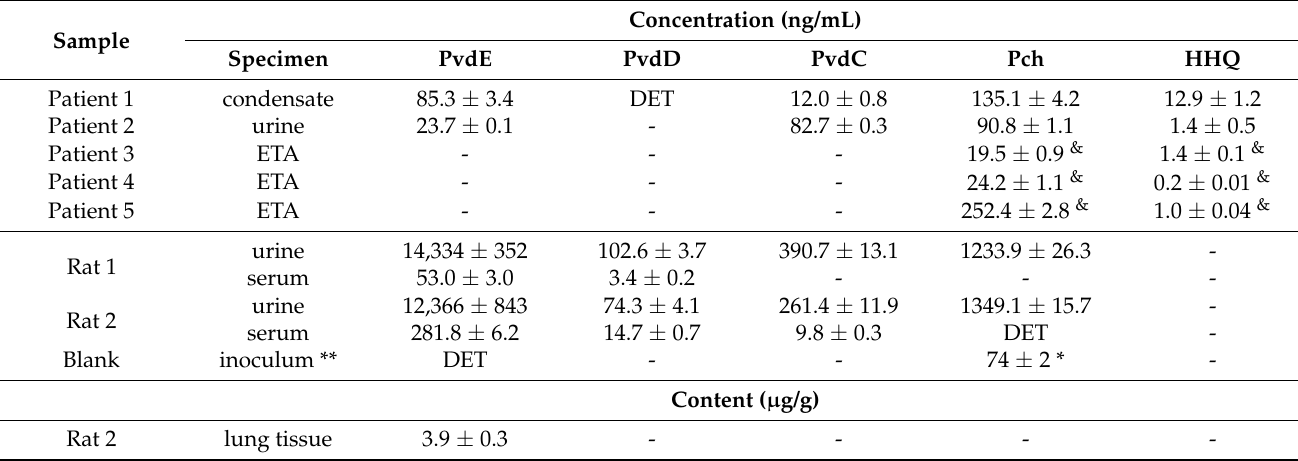
Table 1. Distribution of Pvds, Pch, and HHQ in humans and rats reflects Pseudomonas infection. Urine and breath condensate were collected from two patients on the indicated day. In the rat mono-infection model, two animals were inoculated with P. aeruginosa cells, and samples of their urine, serum, and tissues were collected five hours post-inoculation. Background Pvd signal in the inoculum ** (mono-infection model, sample Blank) was negligible, in contrast to Pch. * Quantified based on single-point calibration; DET, detected (value between LOD and LOQ); -, not detected; ETA, endotracheal aspirate; & Standard deviation is calculated from the measurement precision of the corresponding matrix-matched calibrators.